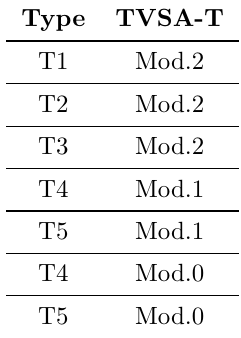
Table 2. Types of spacing